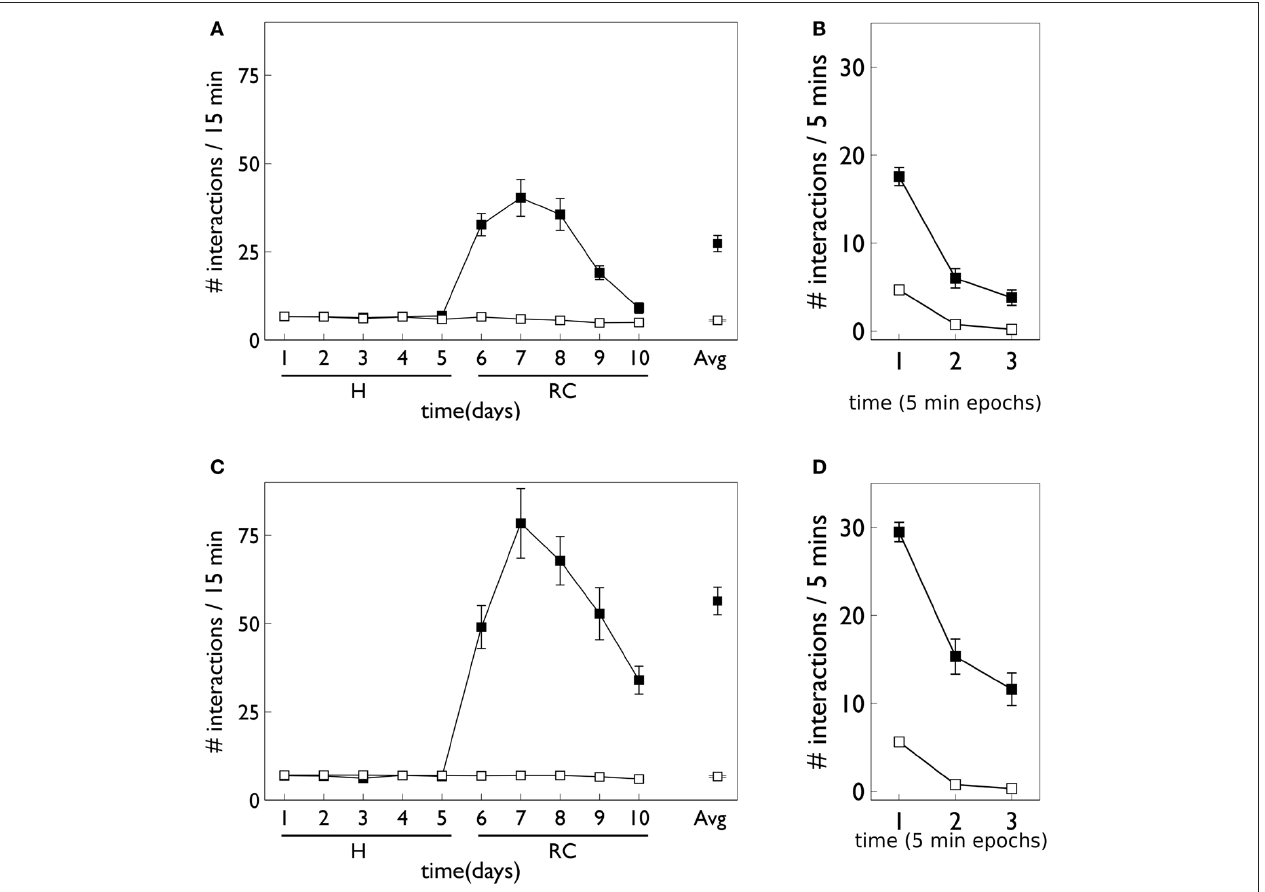
FIGURE 9 | Behavior of an agent with novelty salience and feature prediction performing the block-bumping experiment with variable interval training. (A,C) Have a similar interpretation to counterparts in Figure 8